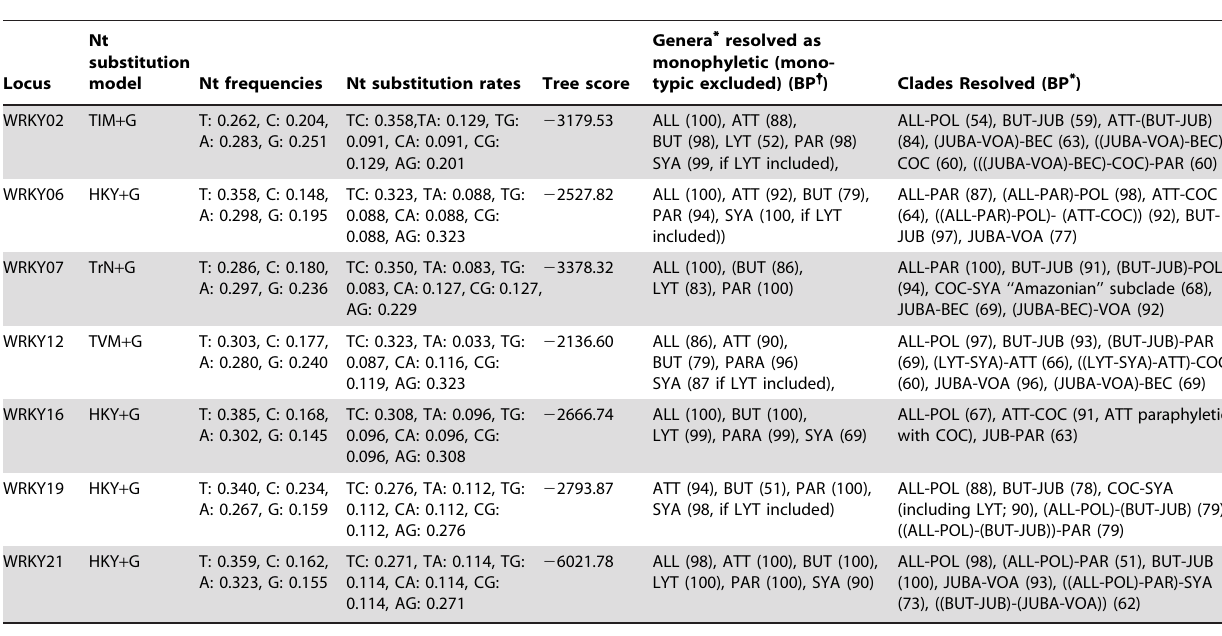
Table 3. Results of maximum likelihood analyses of subtribe Attaleinae with seven WRKY loci.